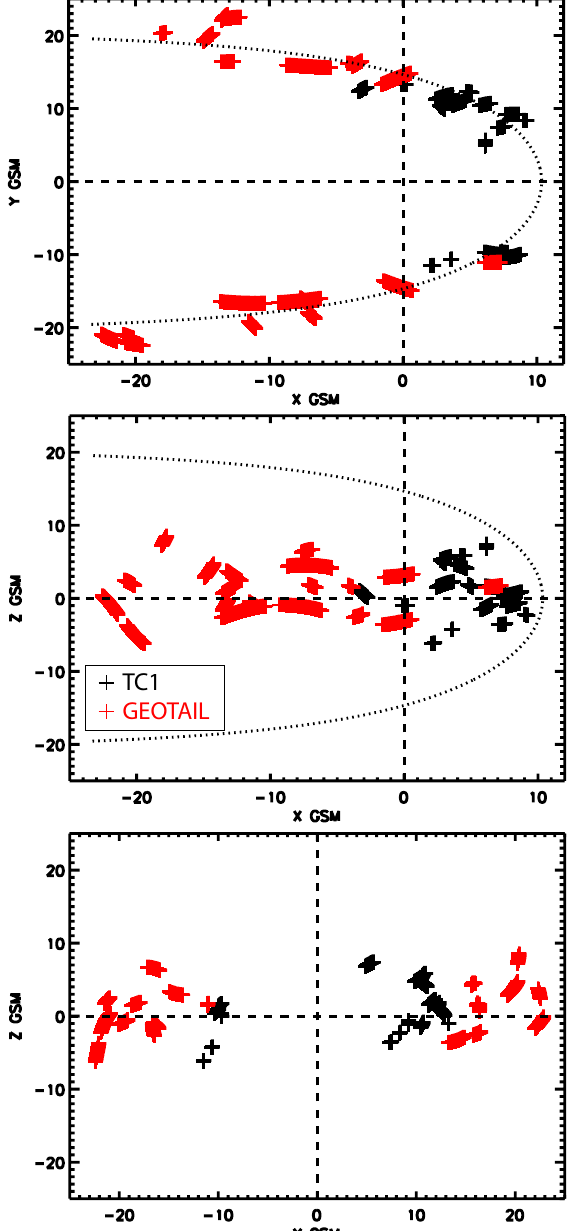
Fig. 4. Location of all events from current study combined with Geotail events from H2006m with Geotail locations in red and TC1 locations in